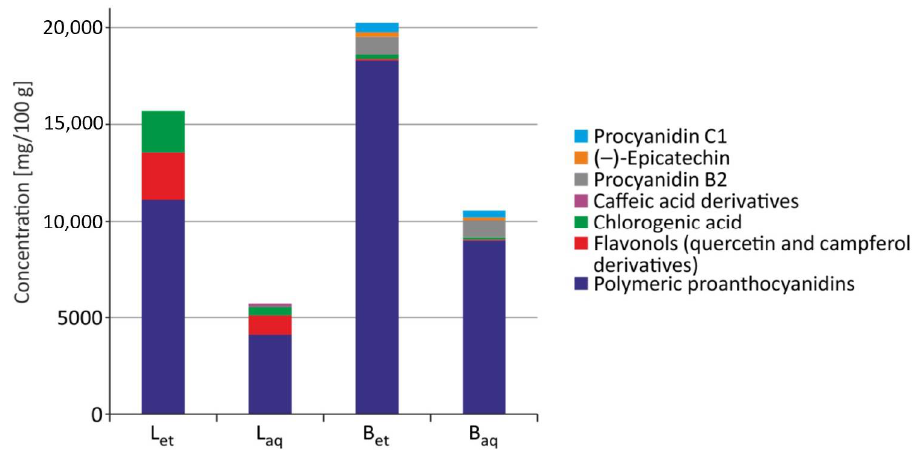
Figure 6. Polyphenols content in the extracts from leaves and bark of U. tomentosa (B et –ethanolic extract from the bark; B aq –aqueous extract from the bark; L et –ethanolic extract from leaves; L aq –aqueous extract from leaves) [17].